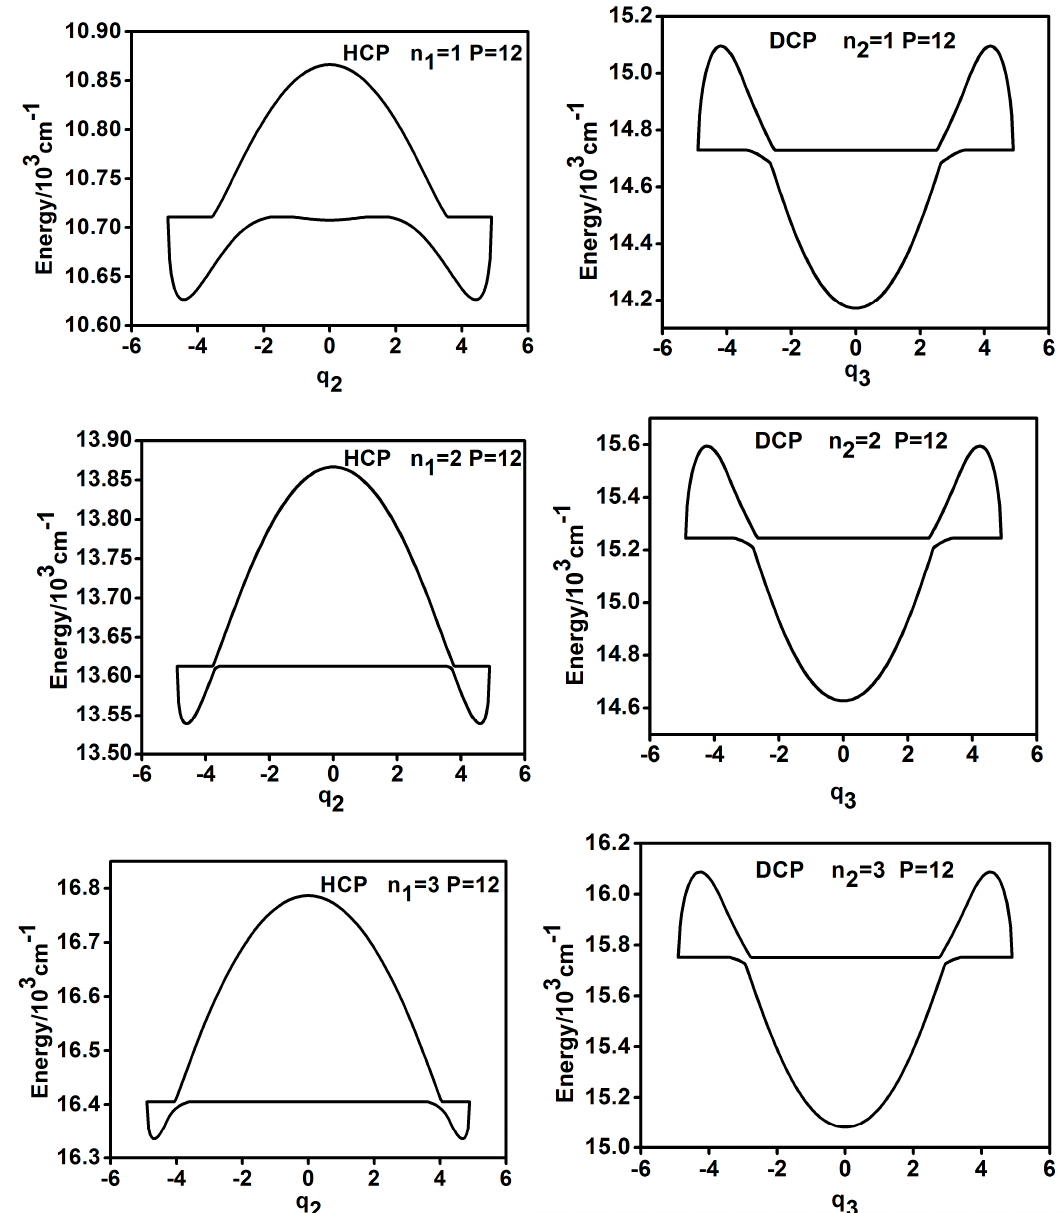
q ) and DCP ( 2 ) and DCP ( q 3 ) when n un > 0 ( P = 2